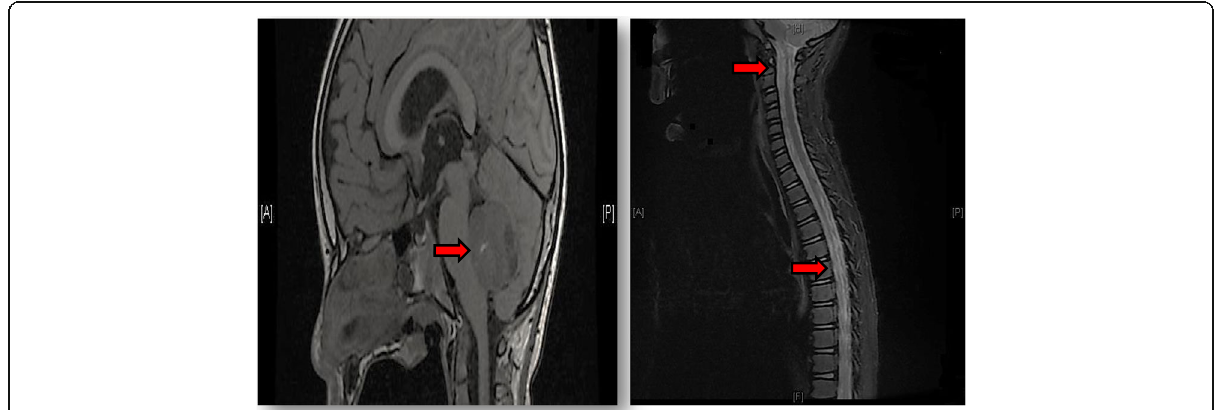
Fig. 2 Brain and spine MRI showed a midline posterior fossa tumor suggestive of medulloblastoma with leptomeningeal enhancement concerning for intraspinal seeding